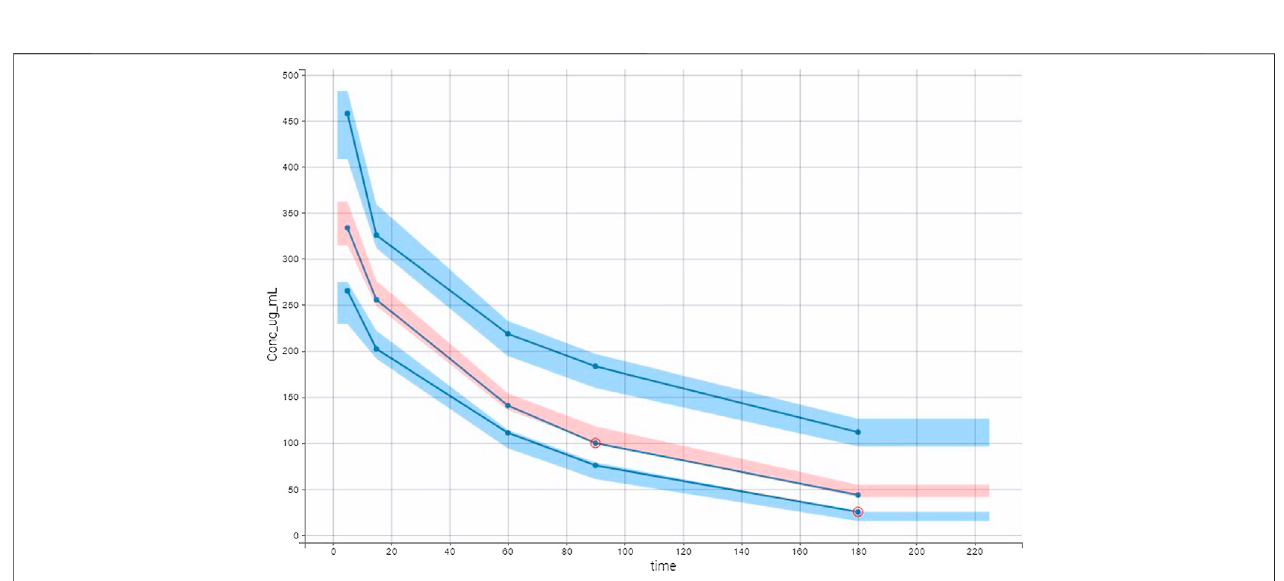
FIGURE 3 | Visual predictive check (VPC) plot was obtained with empirical data (blue lines) and simulated data. Multiple Monte Carlo simulations allowed de fi ning theoretical percentiles (10 th , 50 th , and 90 th ) and their prediction interval. Empirical and theoretical percentiles are superposed showing that the model well described the